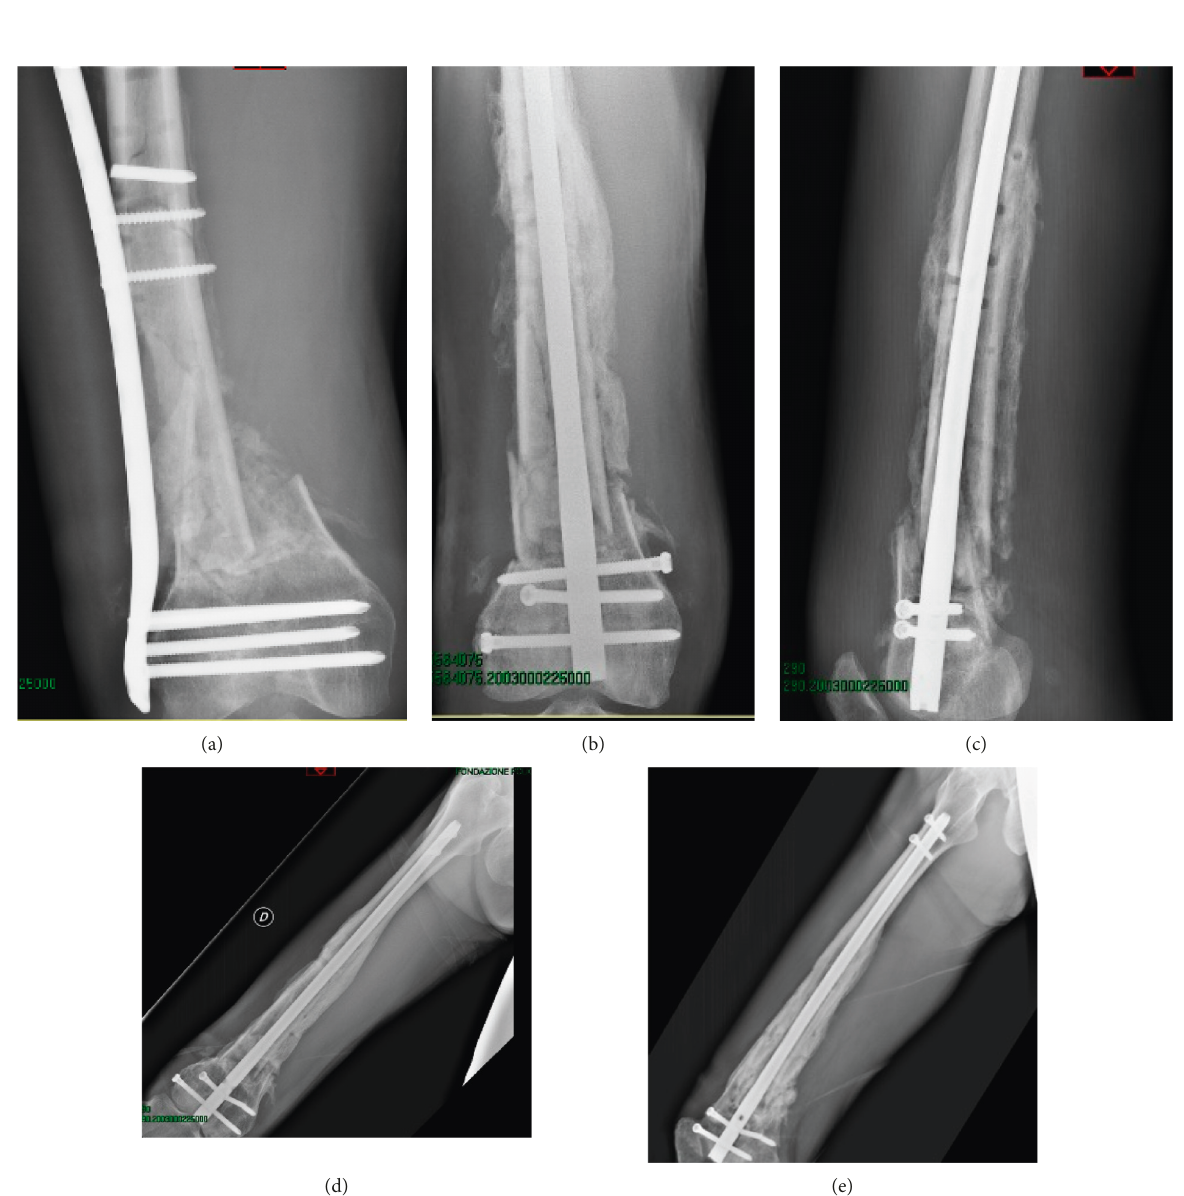
Figure 1: (a) Preoperative nonunion. (b, c) Two-month postoperative nonunion treated with a retrograde nail. (d, e) Twelve-month